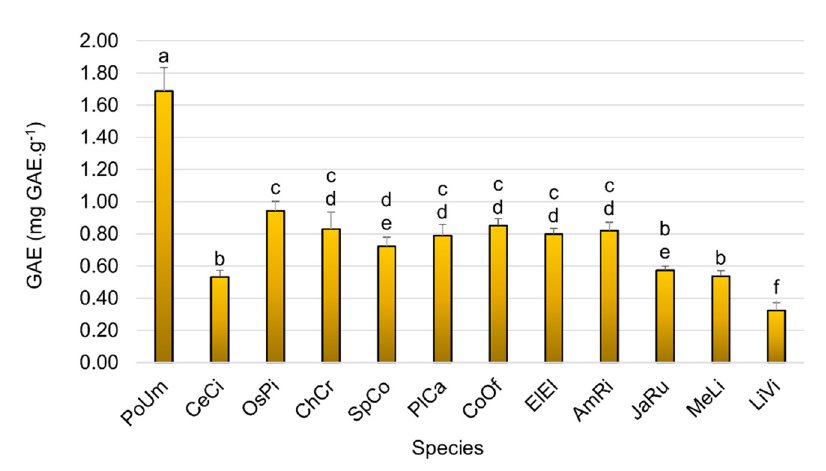
Figure 2. TPC of the twelve studied red seaweed species expressed in mg GAE.g − 1 . PoUm: Porphyra